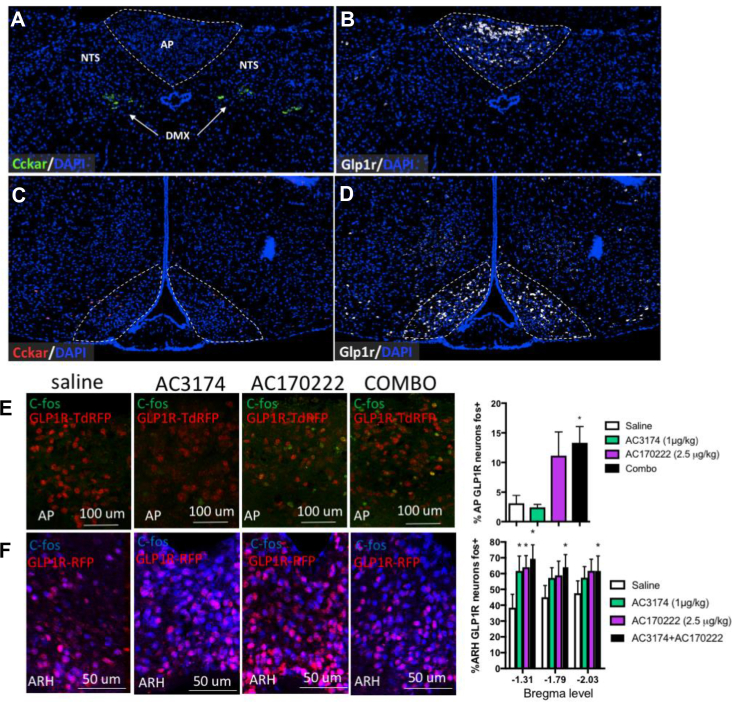
GLP-1R and CCK1R co-agonism did not integrate within CCK1R or GLP-1R neurons. Representative images showing Cckar (A and D) and Glp-1r (B and C) distribution in the AP, NTS, and ARH. Representative images and quantification of neuronal activation in AP (E), ARH (F), or GLP-1R neurons in response to an i.p. administration of saline, GLP-1R agonist AC3174 (1 μg/kg), CCK1R agonist AC170222 (2.5 μg/kg), or AC3174 + AC170222 (1 μg/kg + 2.5 μg/kg). Data are means ± sem. ∗p < 0.05 vs saline.